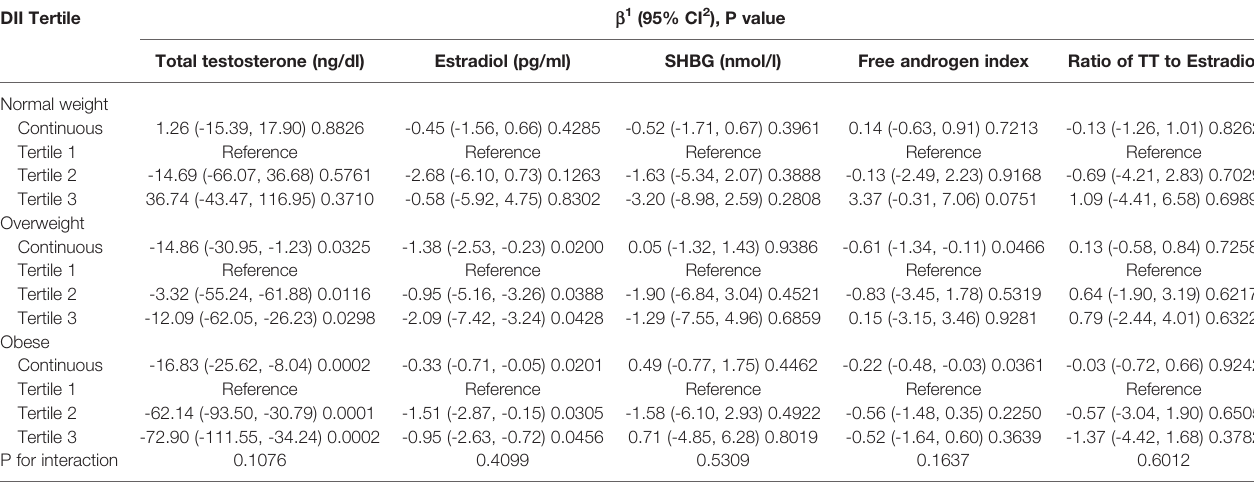
TABLE 3 | Subgroup analysis of association between DII and sex hormone strati fi ed by BMI groups in adolescents aged 12-18. DII Tertile b 1 (95% CI 2 ), P value Total testosterone